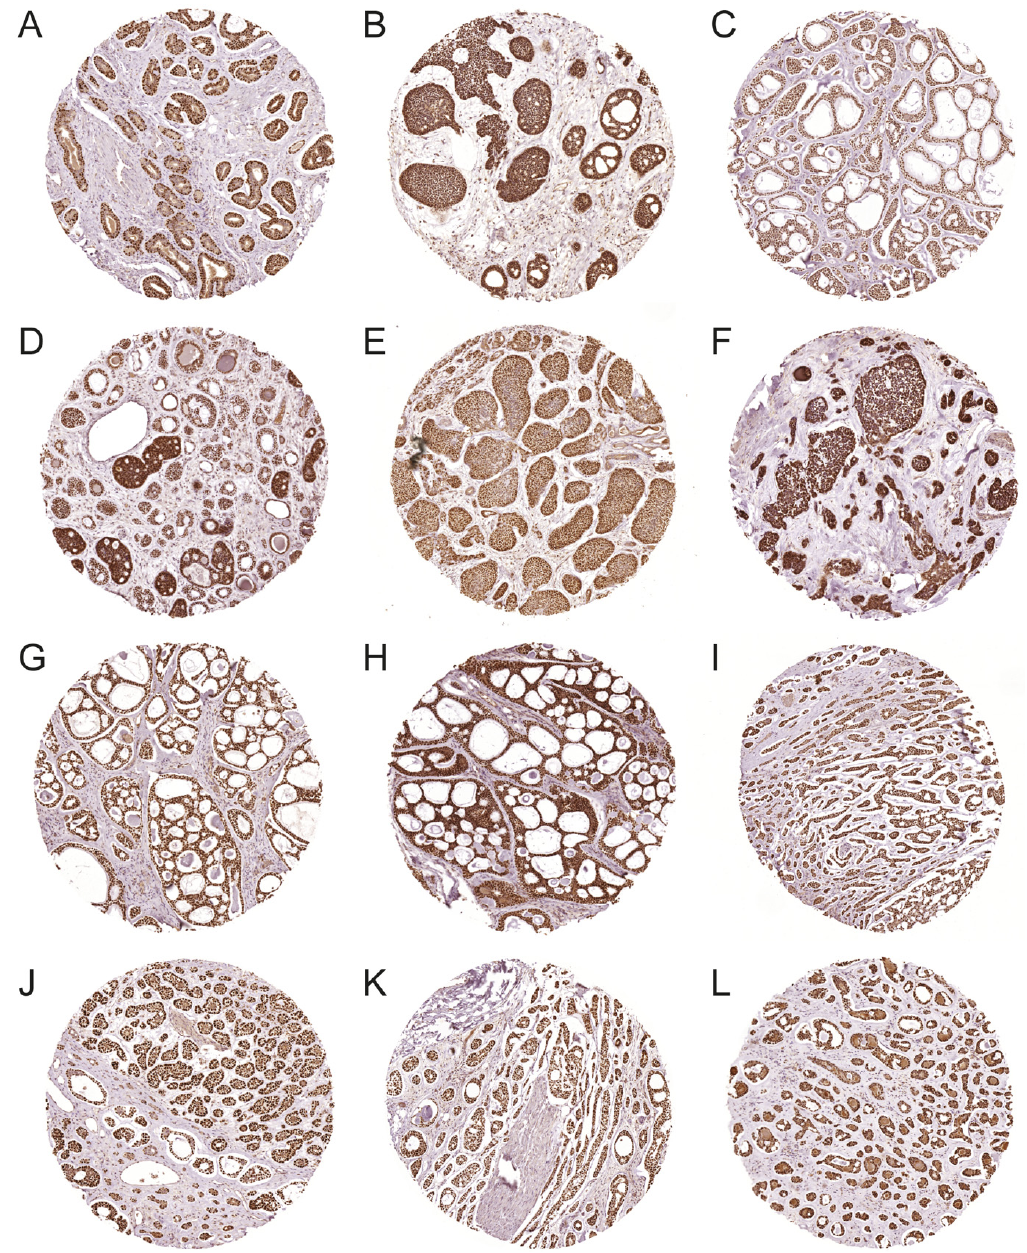
Figure 3. IHC staining of the MYB and MYBL1 oncoproteins in ACC tissue microarrays. ( A – C ) MYB staining in three ACCs with MYB split signals. ( D – F ) MYB staining in three ACCs with loss of the